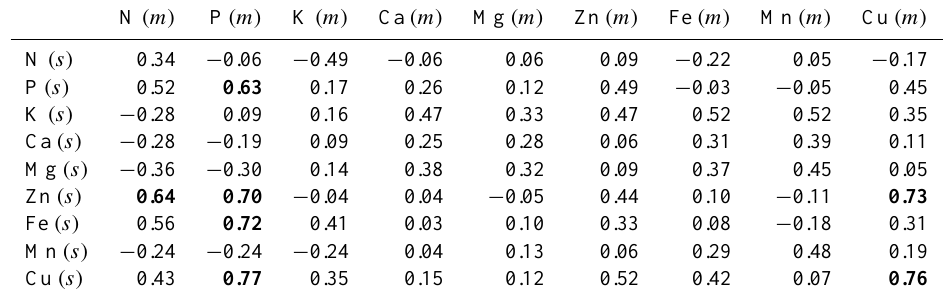
Table 7. Correlation between soil macro- and micronutrients available and total plant amounts in the dry matter of mosses on Potter peninsula.